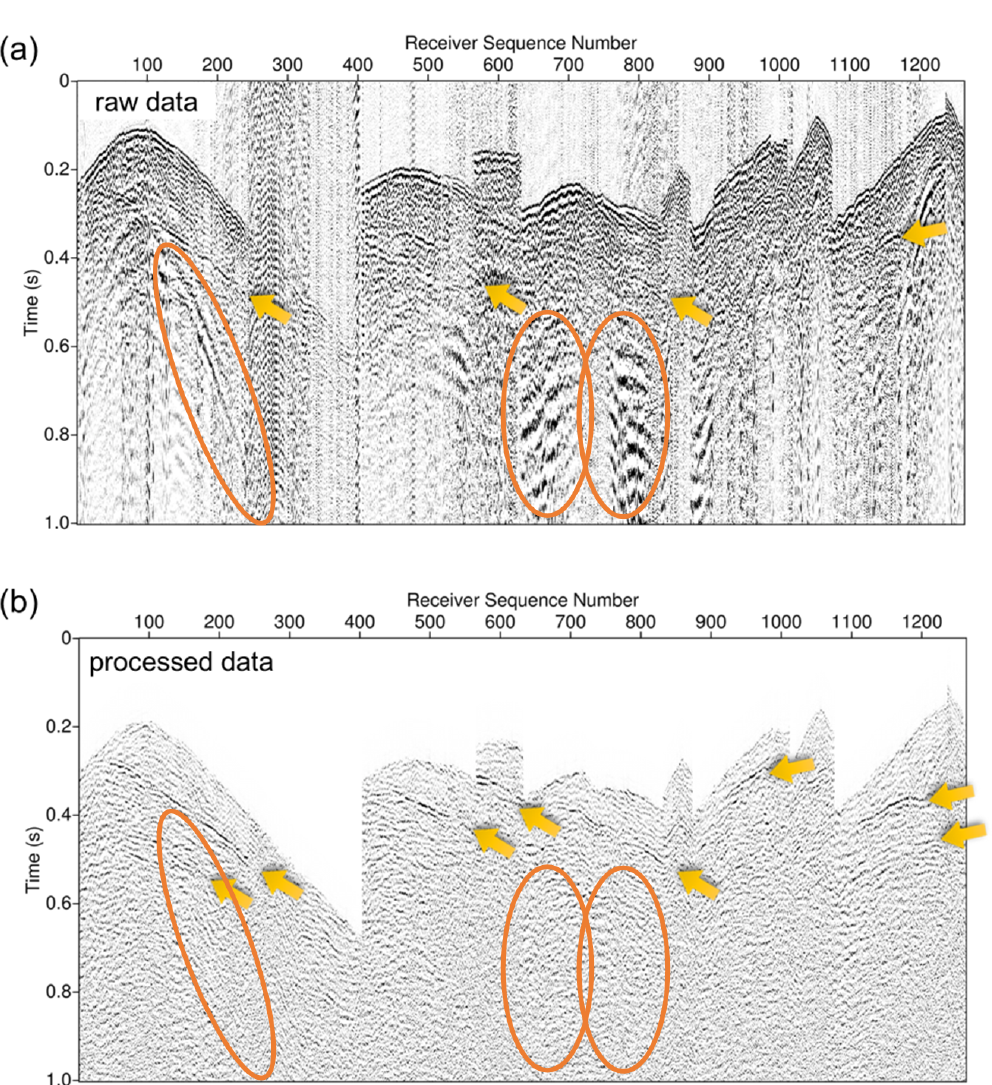
Figure 4. An example shot gather of (a) the raw data and (b) the data after pre-processing as described in Table 2. The source position of the shown shot gather is located close to receiver number 1250. The yellow arrows mark some visible reflections interpreted as being caused by the mineralization in the data; the orange ellipses exemplary mark surface waves present in the raw data.